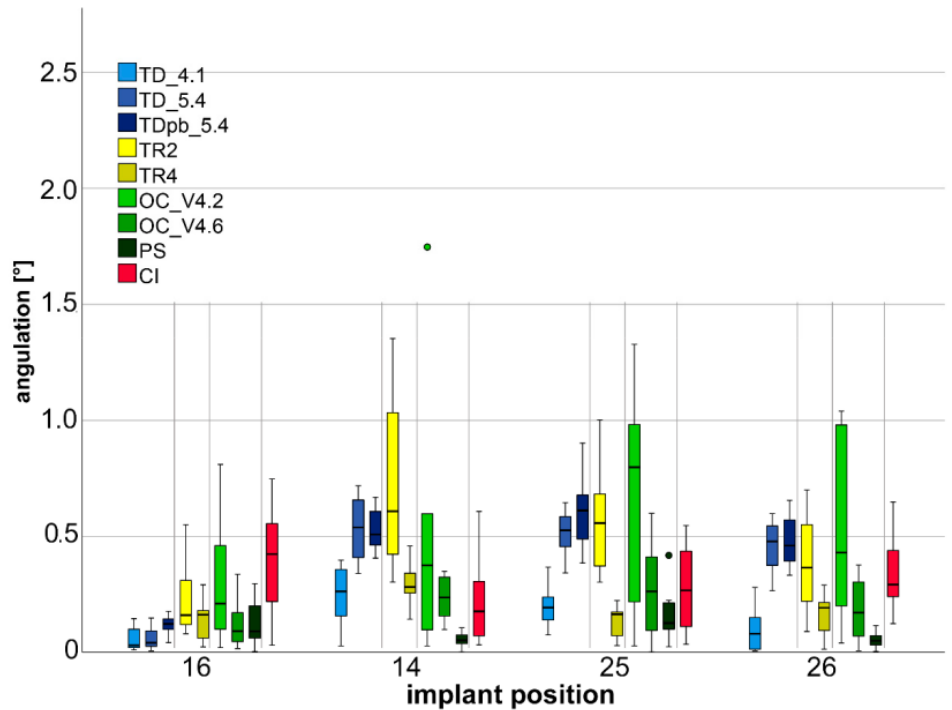
Figure 5. Results for the angulation deviations for the implant positions for each intraoral